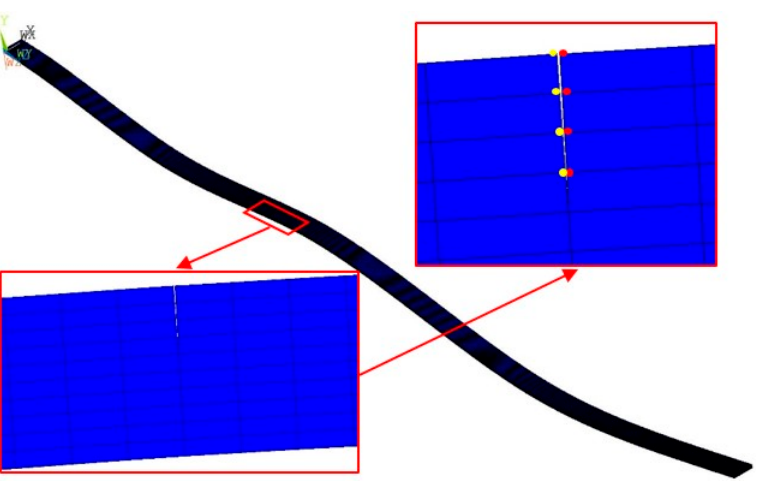
Figure 3. The fourth mode shape of the cracked beam with a zoomed-in view of Crack II (nodes on two crack interfaces are marked by red and yellow dots).